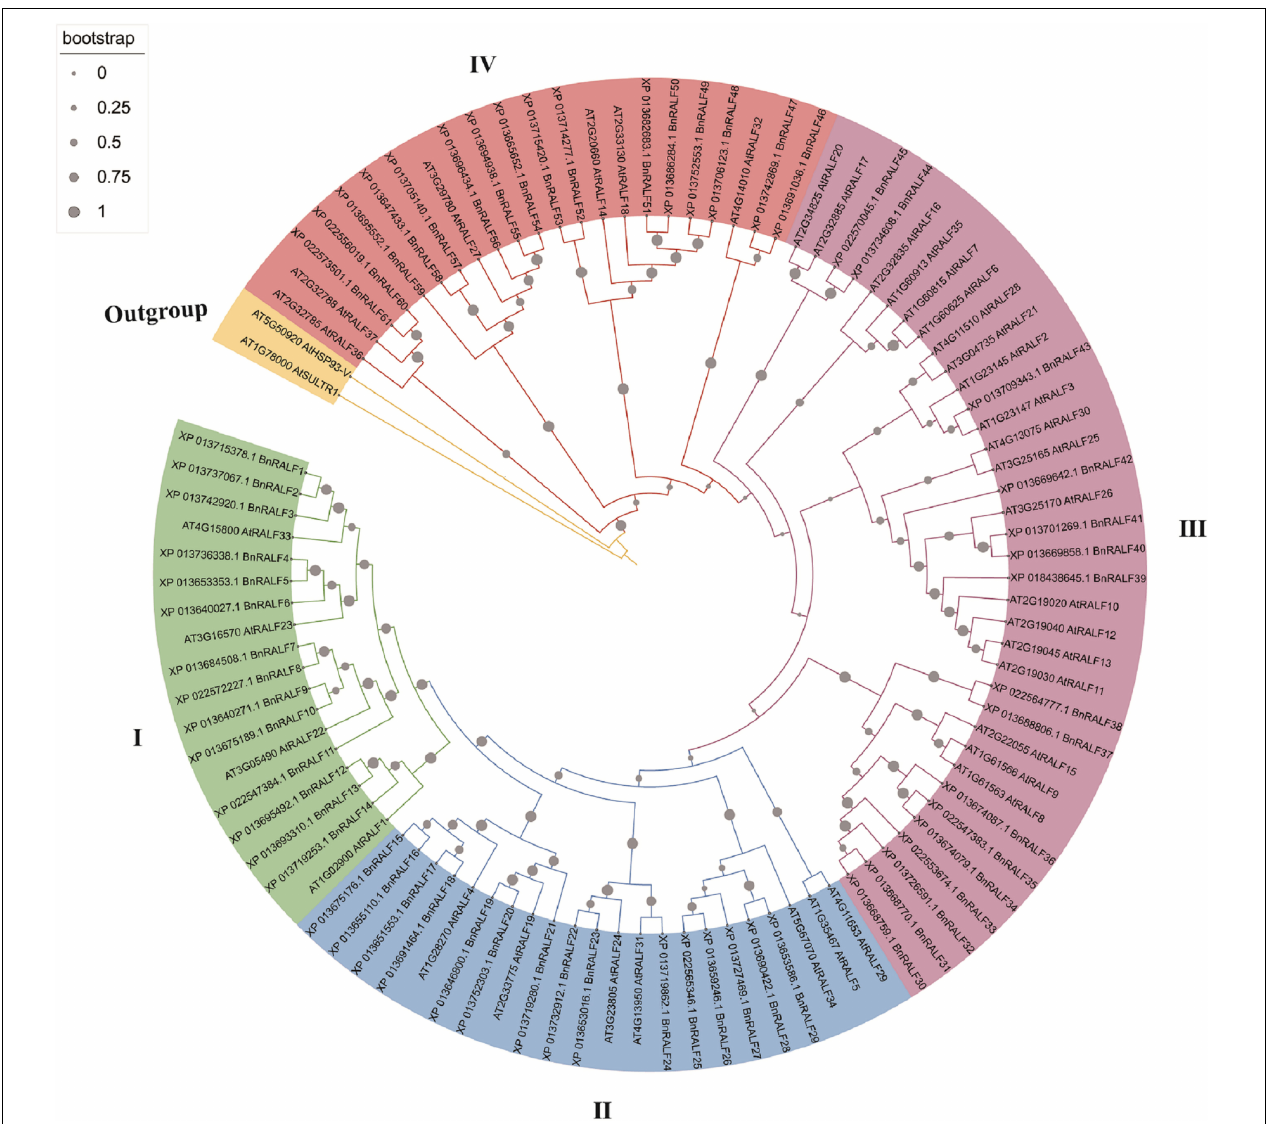
FIGURE 1 | Phylogenetic tree of B. napus and A. thaliana RALF proteins. Full-length protein sequences were aligned using MUSCLE. The phylogenetic tree was constructed employing the UPGMA method with 1,000 bootstrap values in MEGA-X software, and was optimized with the iTOL online tool. The clades were marked with different colors. The gray filled circles in the branch indicate bootstrap